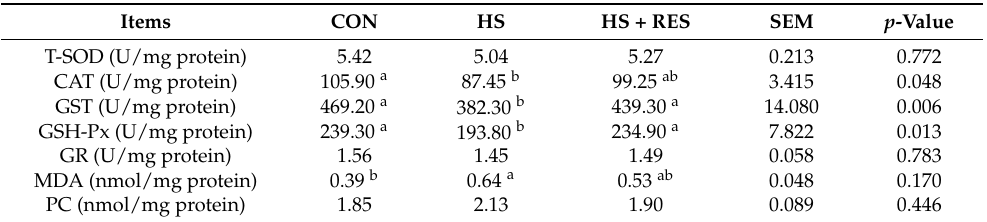
Table 4. Effects of RES on antioxidant status and metabolite content in the skeletal muscle of heat- stressed broilers.